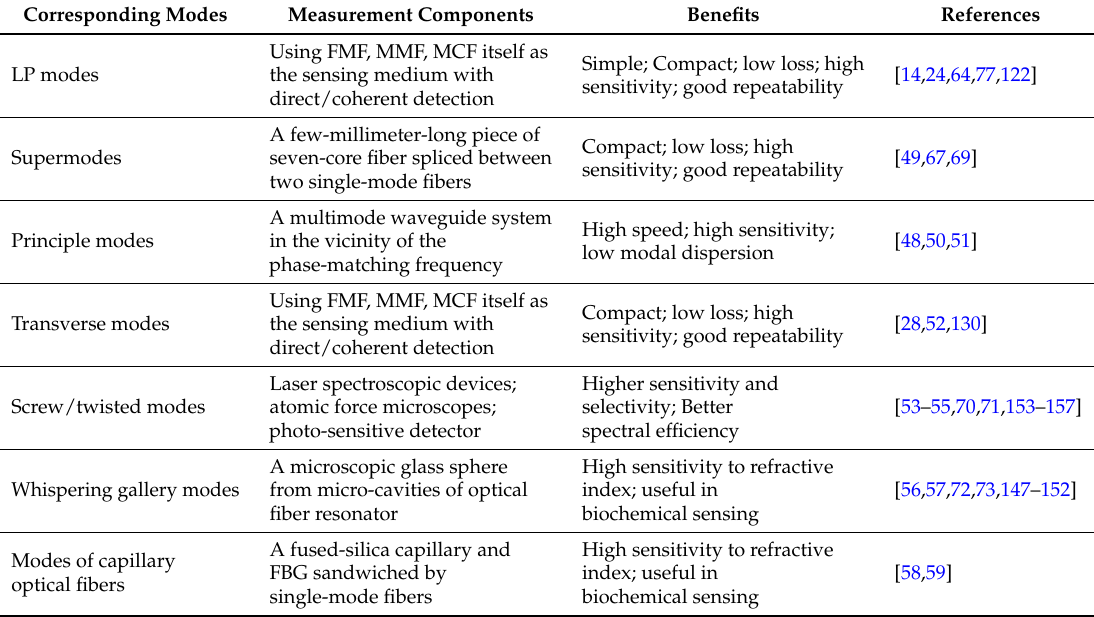
Table 7. Comparison of key components and multiplexing benefits using different types of